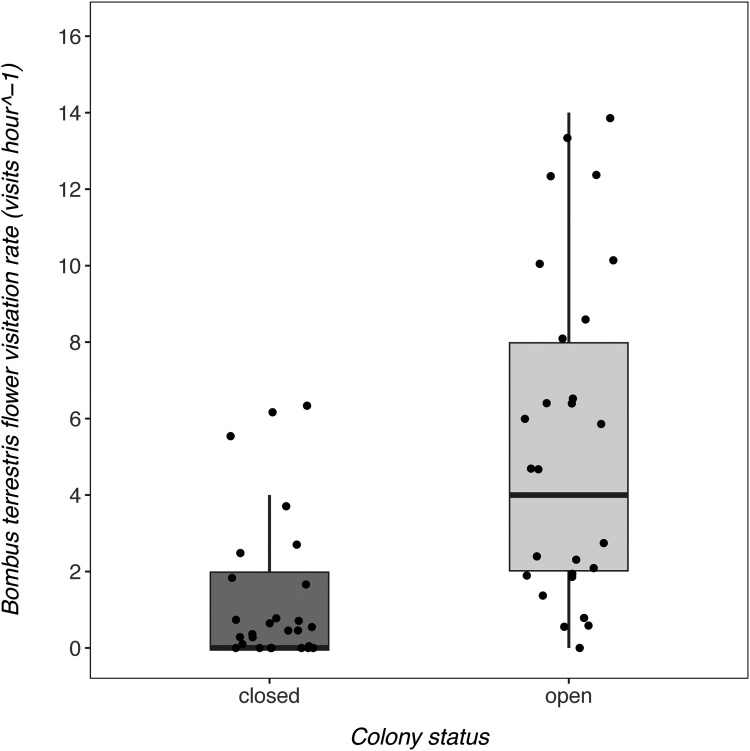
The flower visitation rate (visits hour−1) of B. terrestris audax on strawberry flowers in the June-bearing crop. The median (central horizontal line), quartiles (box), non-outlier ranges (vertical lines) and raw data (dots) are presented on the plot.